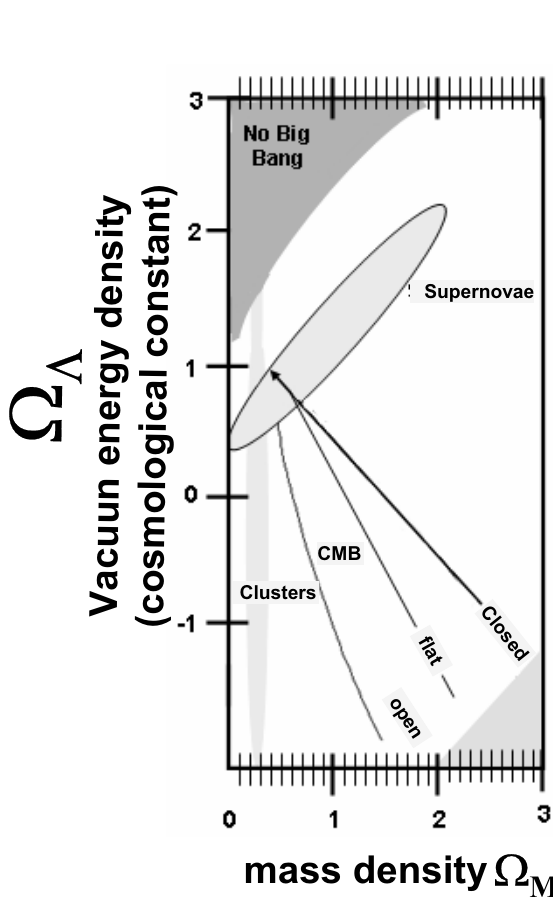
Fig. 3 – The acceptable zones in the (cid:4)(M) and (cid:4)((cid:3)) plane which are associated with different measurements. It illustrate the impres- sive ‘‘cosmic convergence’’ met according to the standard